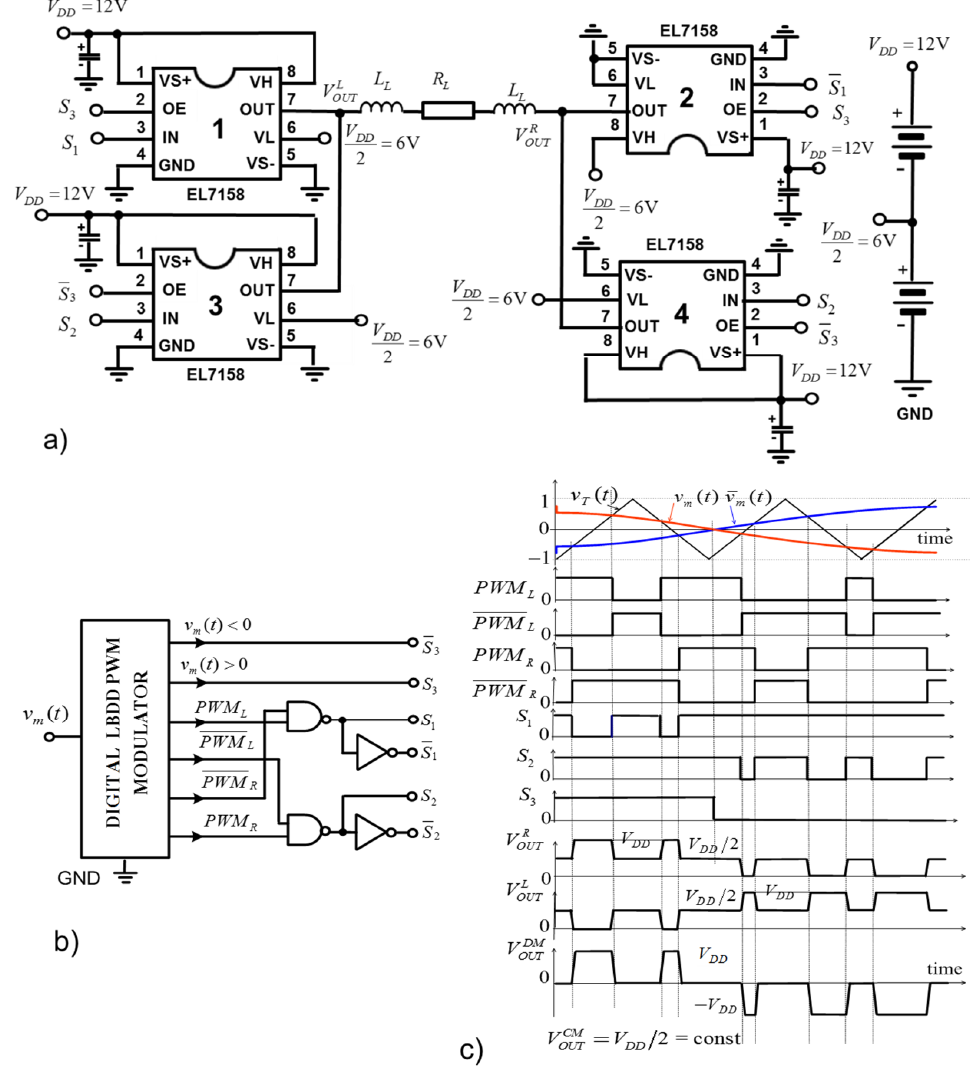
Figure 4. Filterless, digital low-power Class-BD amplifier with constant voltage at the CM output implemented on four ultrahigh-current EL7158 pin drivers: ( a ) circuit diagram; ( b ) the extended digital LBDD PWM modulator; ( c ) control signals and DM and CM output voltages.